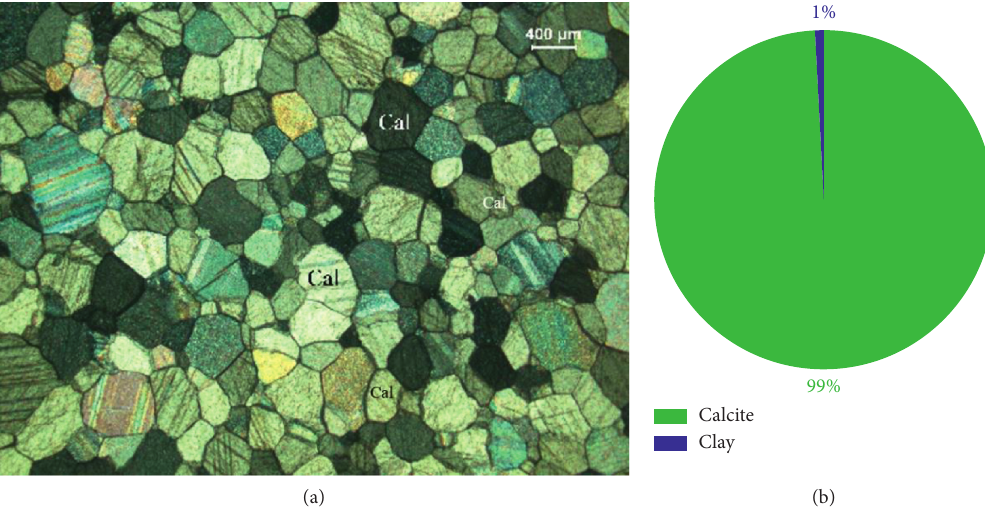
Figure 1: Photomicrographs of marble samples. (a) Single polarization (Cal � calcite) [28]. (b) Composition content.